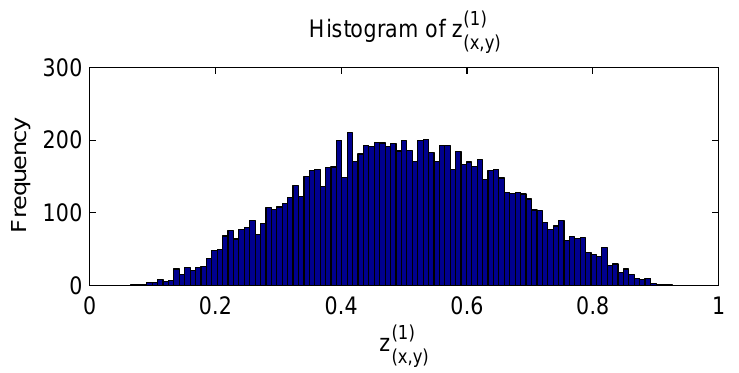
( 1 ) Figure 4. Histogram of z values. It graphically represents the distribution of numerical data of ( x , y ) ( 1 ) z . In addition, the bins are same size of 0.01 and the total frequency is 10,000. Note that it is similar ( x , y ) to the Gaussian distribution, and thus the frequency number is very low at a range of z ( 1 ) ≥ 0.9. Consequently, in the range, it is hard to meet the requirements of | z ( 1 ) z ( x , y ) within R , and thus it fails to set the proper initial weights in RS